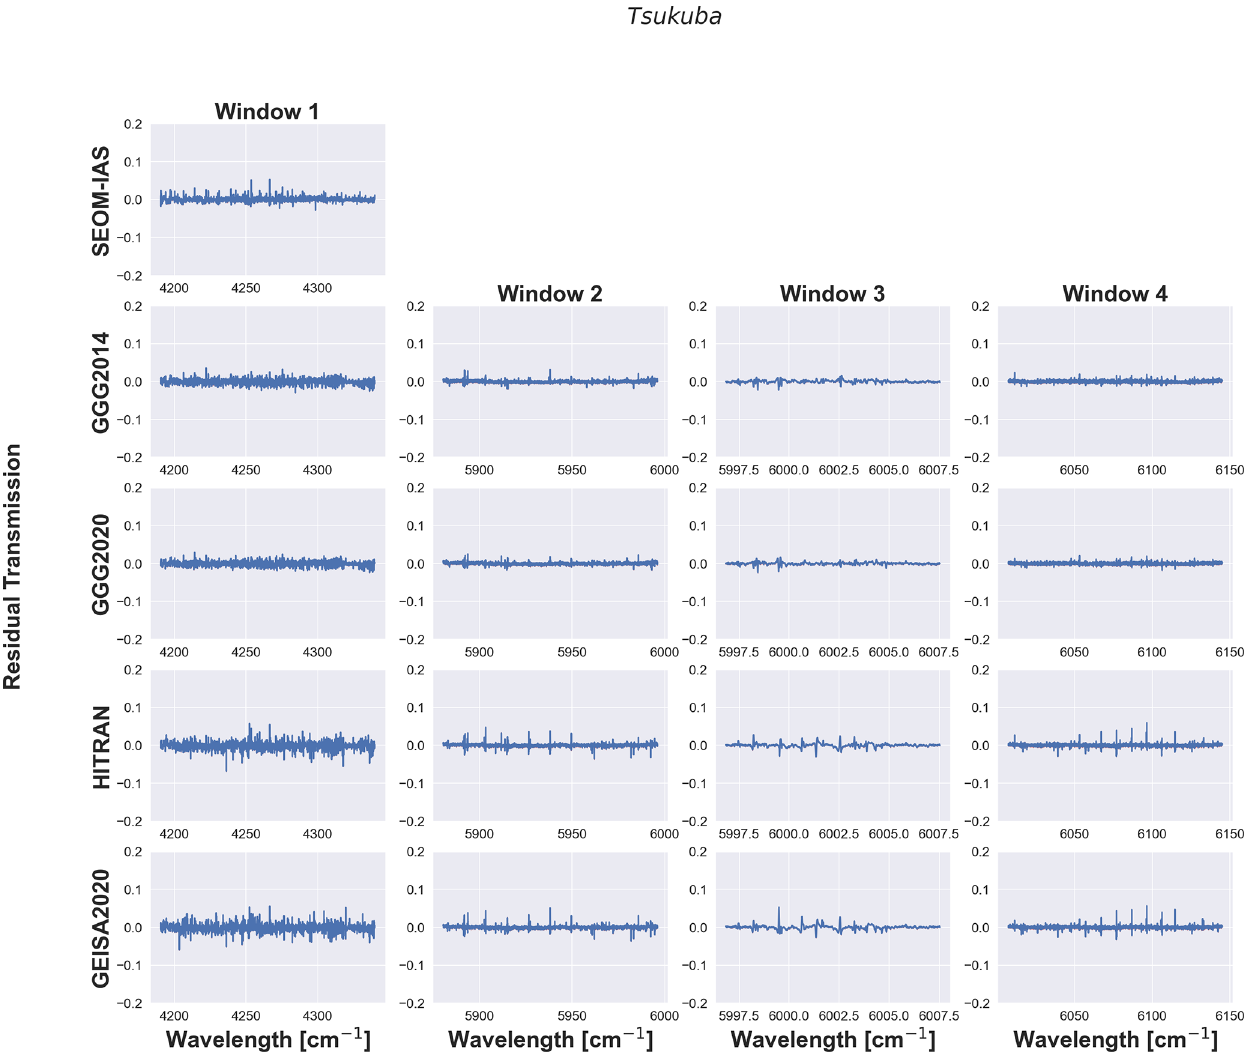
Figure A2. Example residual transmission spectra calculated from measured and fitted spectra from the Tsukuba site in 2019.